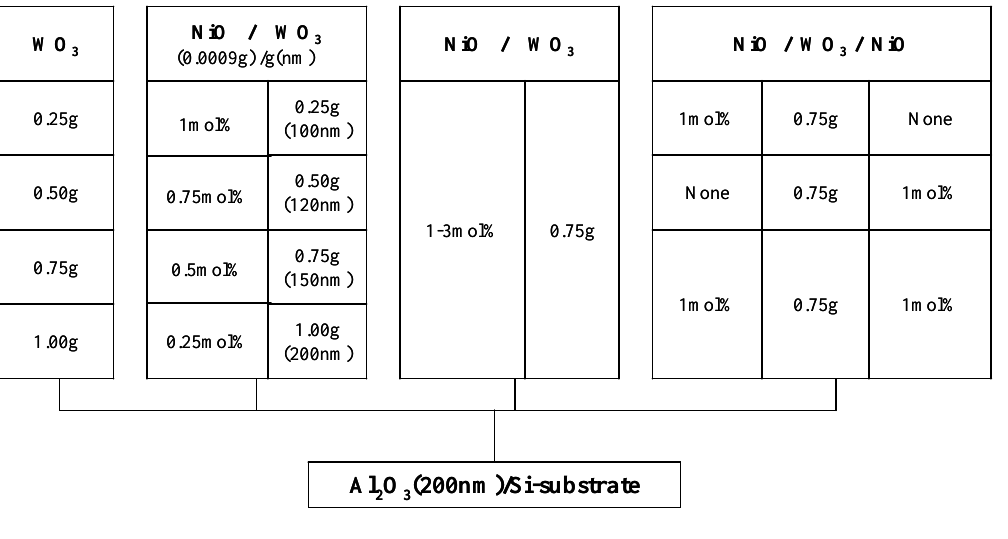
Figure 1. Specimen preparation processes of WO